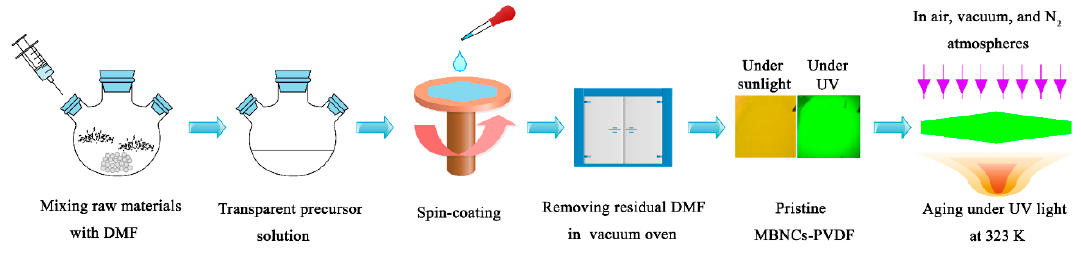
Figure 1. The scheme of the experiments.